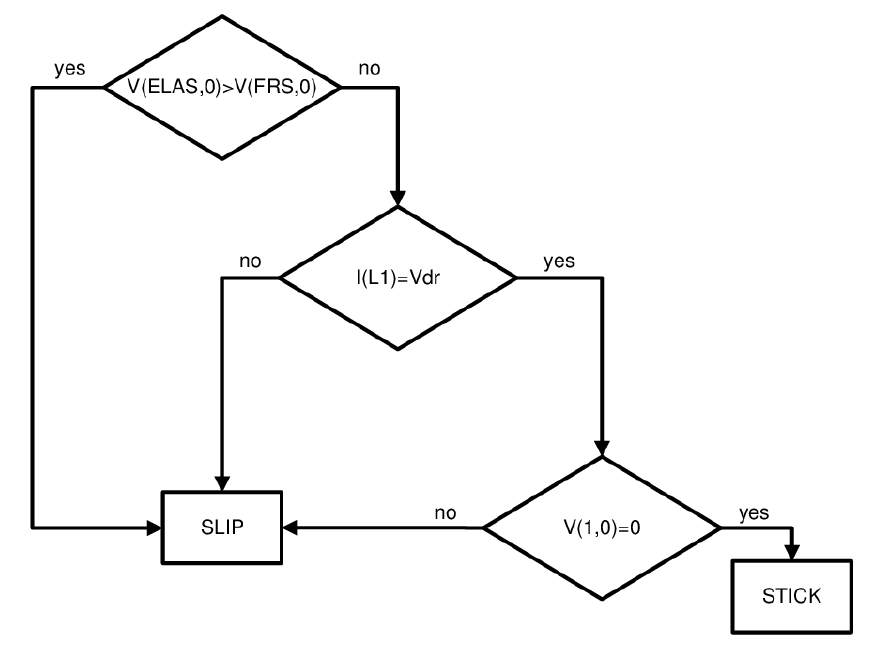
Figure 10 Decision algorithm used to control the switches.